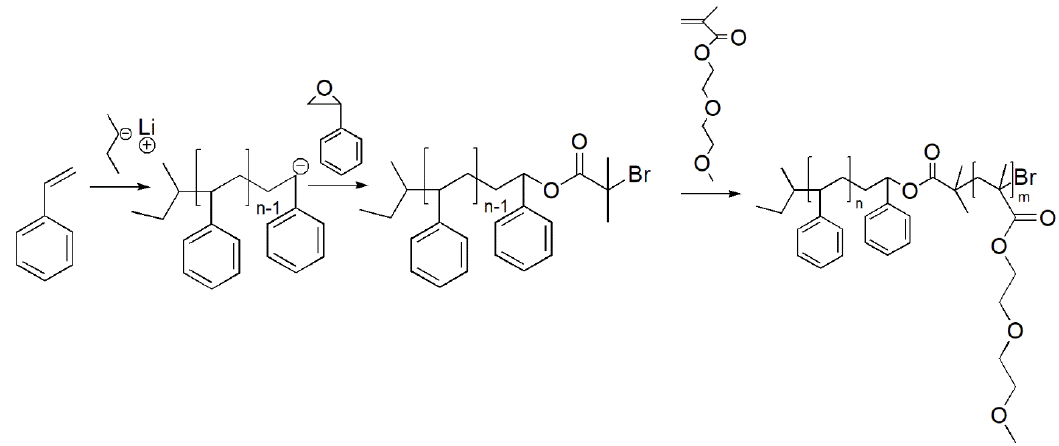
Figure 4. Reaction scheme of the synthesis of PS-b- PDMEEMA block-copolymer combination of SAP and ATRP.